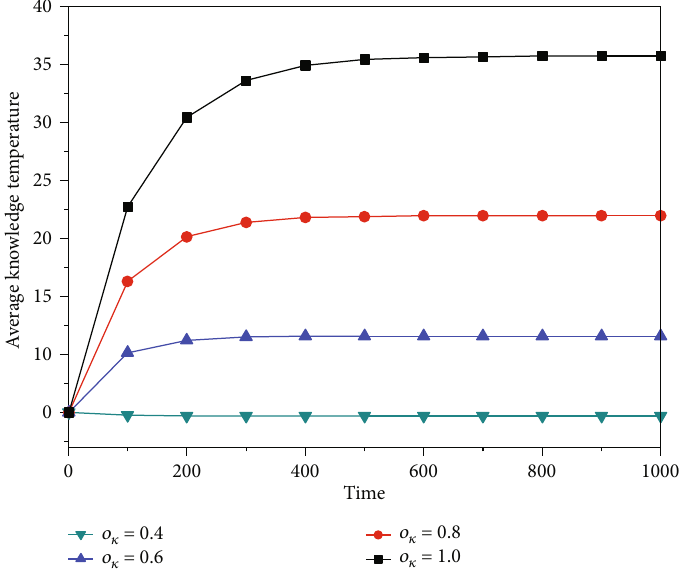
= 1 ), b ( u = 0 : 5 ), c ( u = 0 : 1 )). k k k